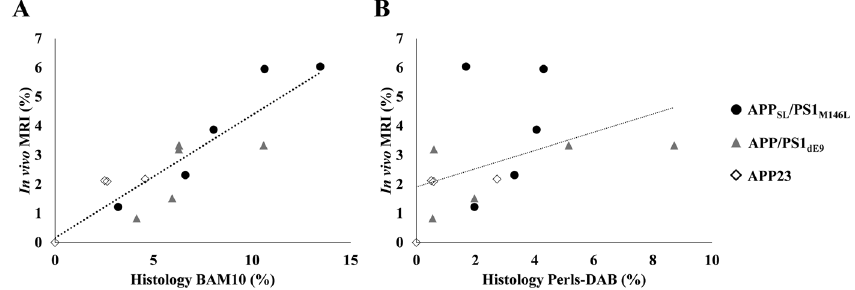
Figure 5. Relationships between amyloid load quantified from in vivo Gd-stained MR images, and from amyloid-stained histological sections (BAM10) ( A ) or from iron-stained histological sections (Perls-DAB) ( B ). Amyloid load measured from Gd-stained MRI showed a correlation with BAM10 staining (R 2 = 0.82; p < 0.01) but was not correlated with Perls-DAB staining (R 2 = 0.35; p > 0.05).